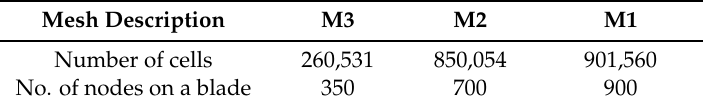
Table 1. Different mesh